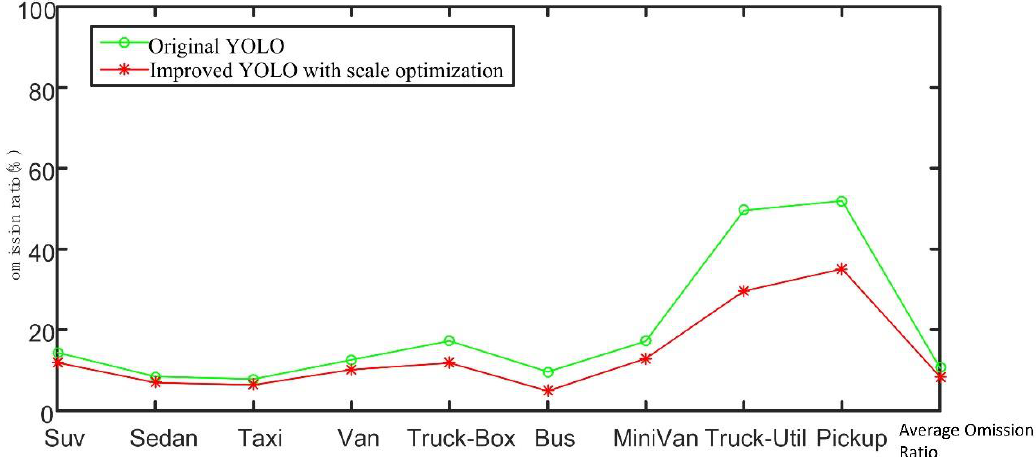
Figure 8. Comparison of omission ratio between the original YOLO algorithm and its improved algorithm.